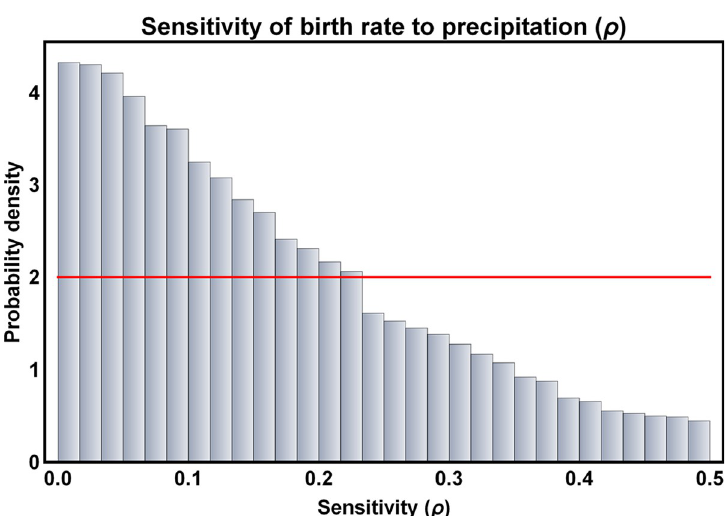
Fig 4. Posterior distribution for the sensitivity of birth rate to average precipitation over the preceding 30 day interval ( ρ ). The red line shows the prior distribution and the bars indicate the posterior probability density.